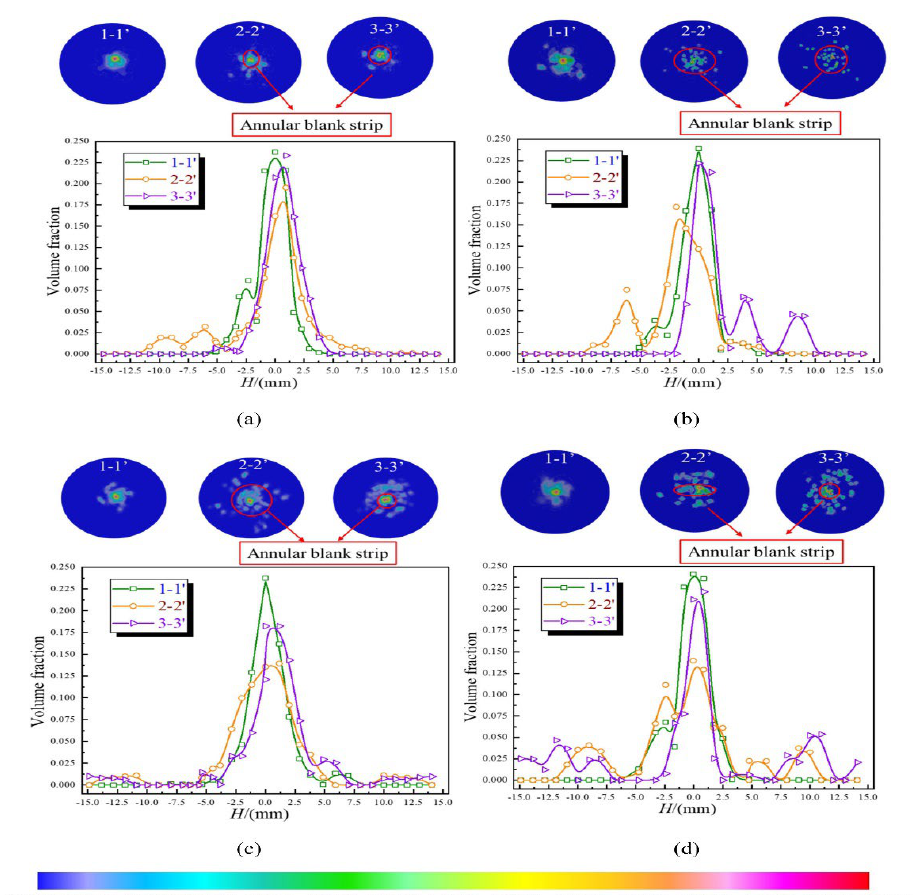
Figure 14. Volume fractions of abrasive particles: ( a ) NPR = 0.6, ( b ) NPR = 1, ( c ) NPR = 1.12 and ( d ) NPR = 2 [129].